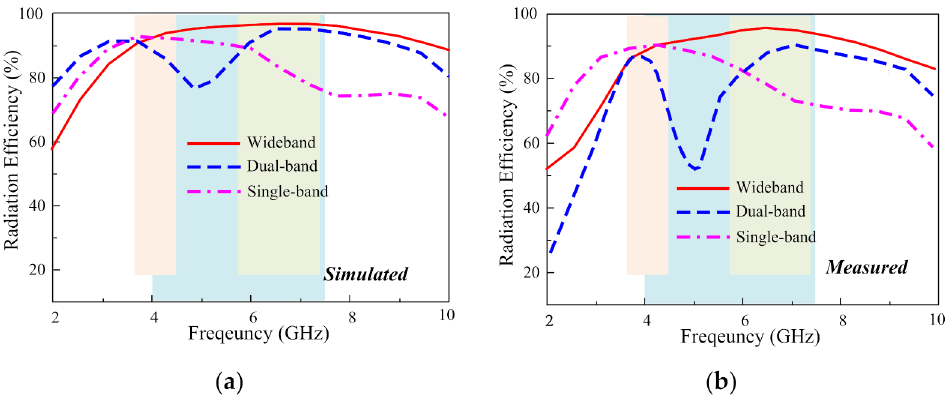
Figure 10. The ( a ) simulated and ( b ) measured radiation efficiency of the proposed antenna for different operating